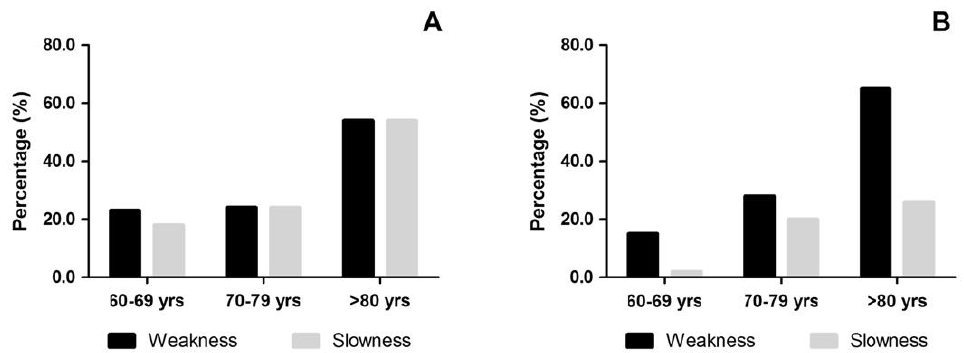
Figure 2. Comparison of the prevalence (%) of muscle weakness with gait slowness in women ( A ) and men ( B ); difference in prevalence in men aged 80 and over ( p = 0.04).